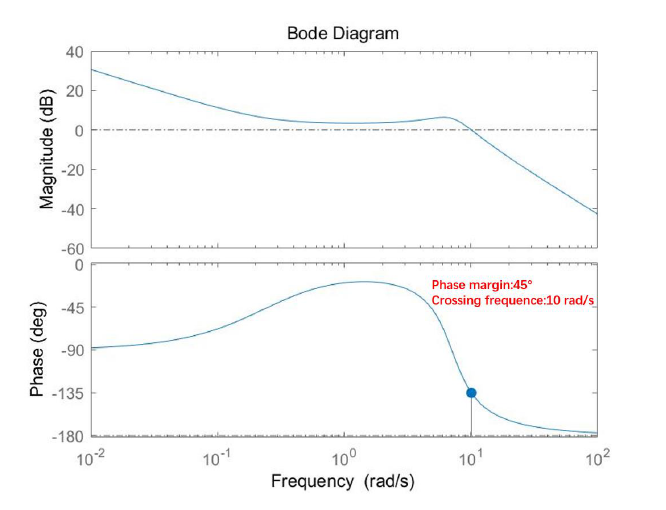
Figure 10. Open-loop frequency domain response of integer order systems.